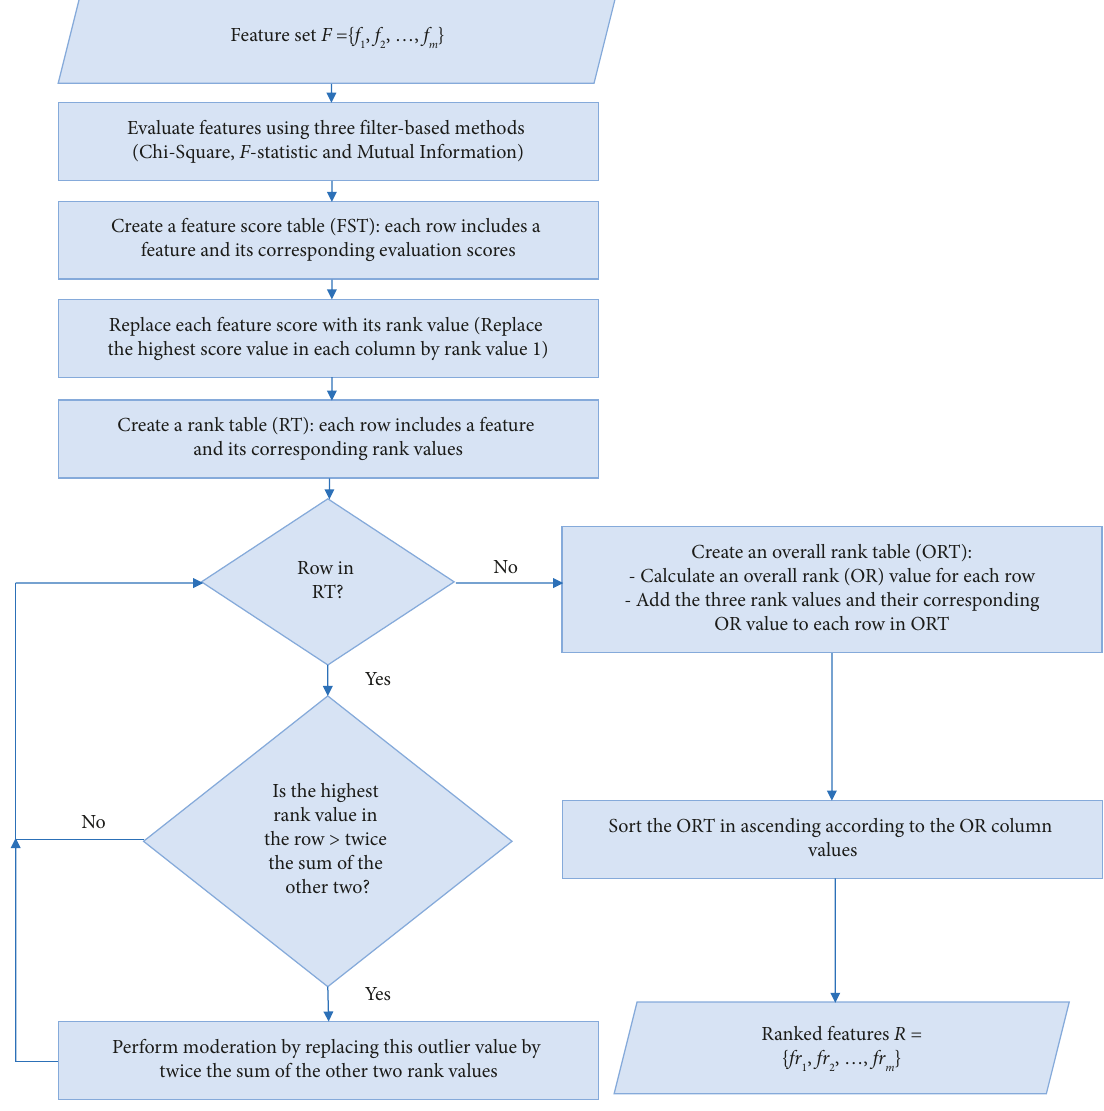
Figure 2: Feature ranking